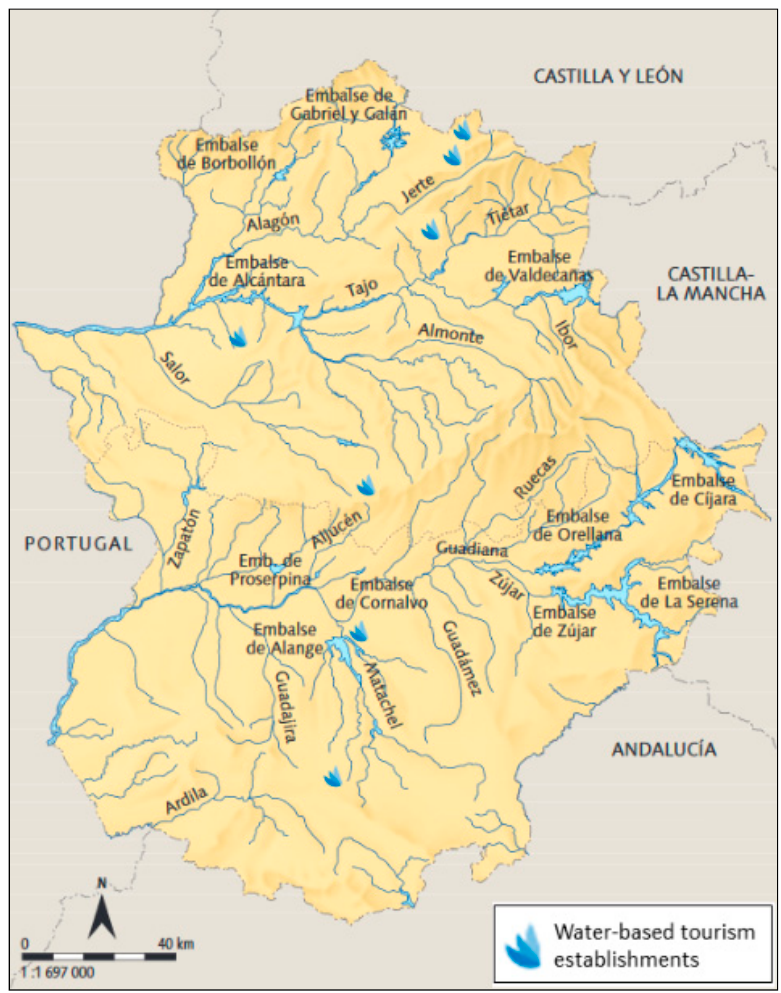
Figure 1. Hydrographic resources of Extremadura and water-based tourism establishments. (Source: Adapted form https://www.actticsociales.com/geografia-3-%C2%BA-eso/clima/el-clima-en- extremadura/ (accessed on 7 November 2018).).